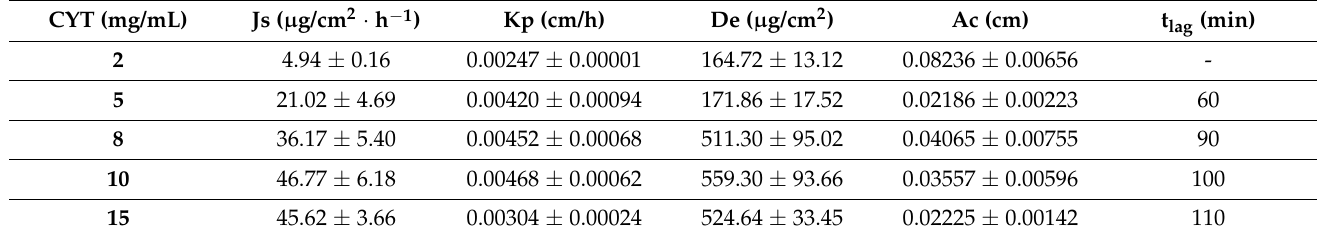
Kp (cm/h), De ( µ g/cm 2 ), Ac (cm) and t lag (min) ± SE (n =